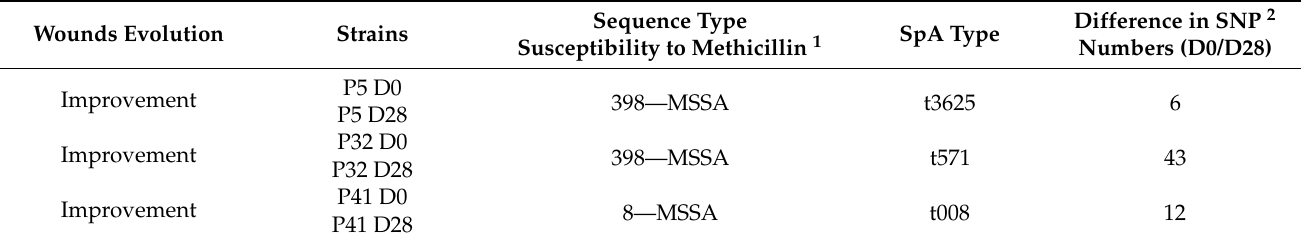
Table 2. Genomic characterisation of S. aureus strains isolated from pressure ulcers at inclusion (D0) and day 28